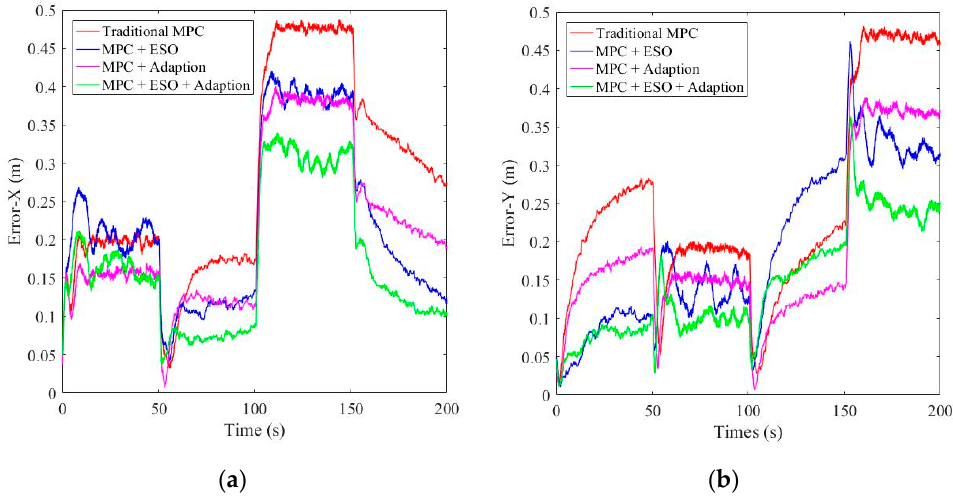
Figure 16. The position error of the robot at the disturbance velocities u = 0.2 m/s and v = 0.2 m/s. ( a ) The trajectory error in the X direction; ( b ) The trajectory error in the Y direction.